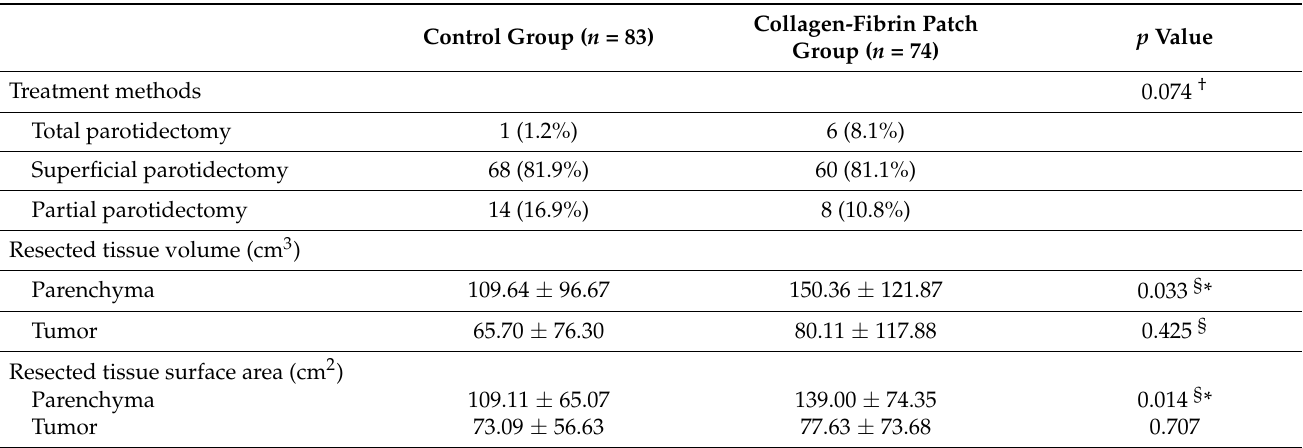
Table 2. Associations between baseline characteristics and primary outcome variables.